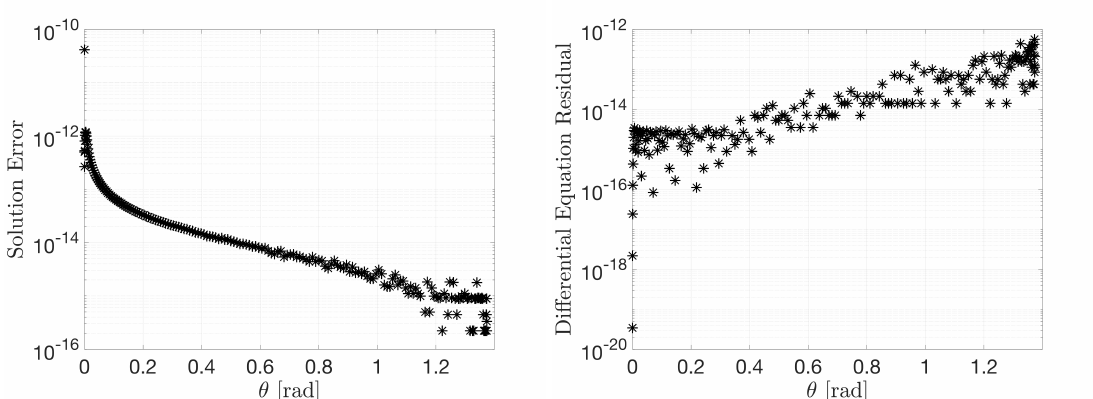
Figure 2. Polar brachistochrone differential equation solution error and